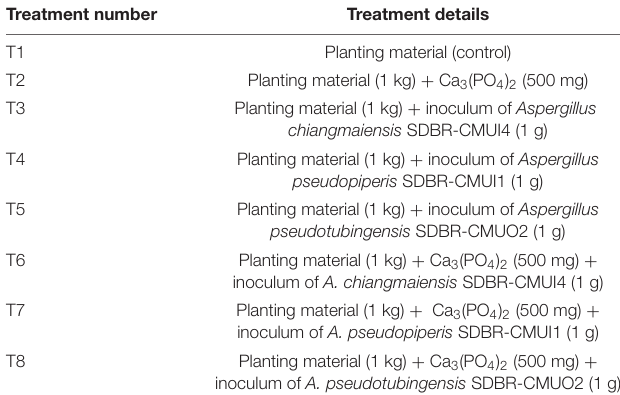
TABLE 1 | Treatment details in this